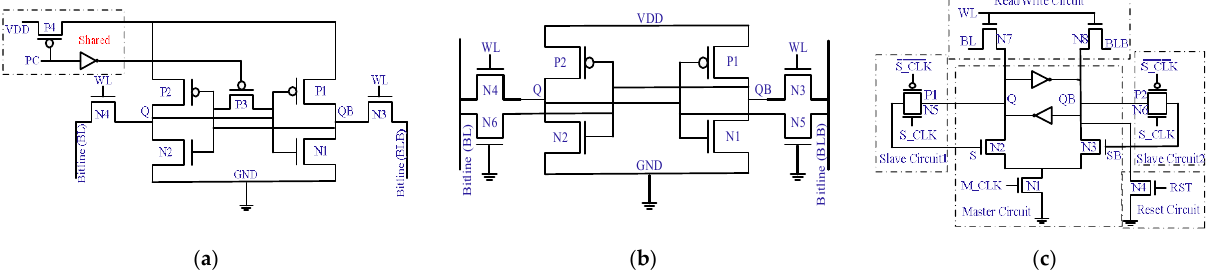
Figure 23. Modified SRAM cell designs for data security. ( a ) SRAM cell with balanced current before read and write operations [74]. ( b ) Incorporating false leakage current information to protect data [78]. ( c ) SRAM cell toggling values to mitigate NBTI effects